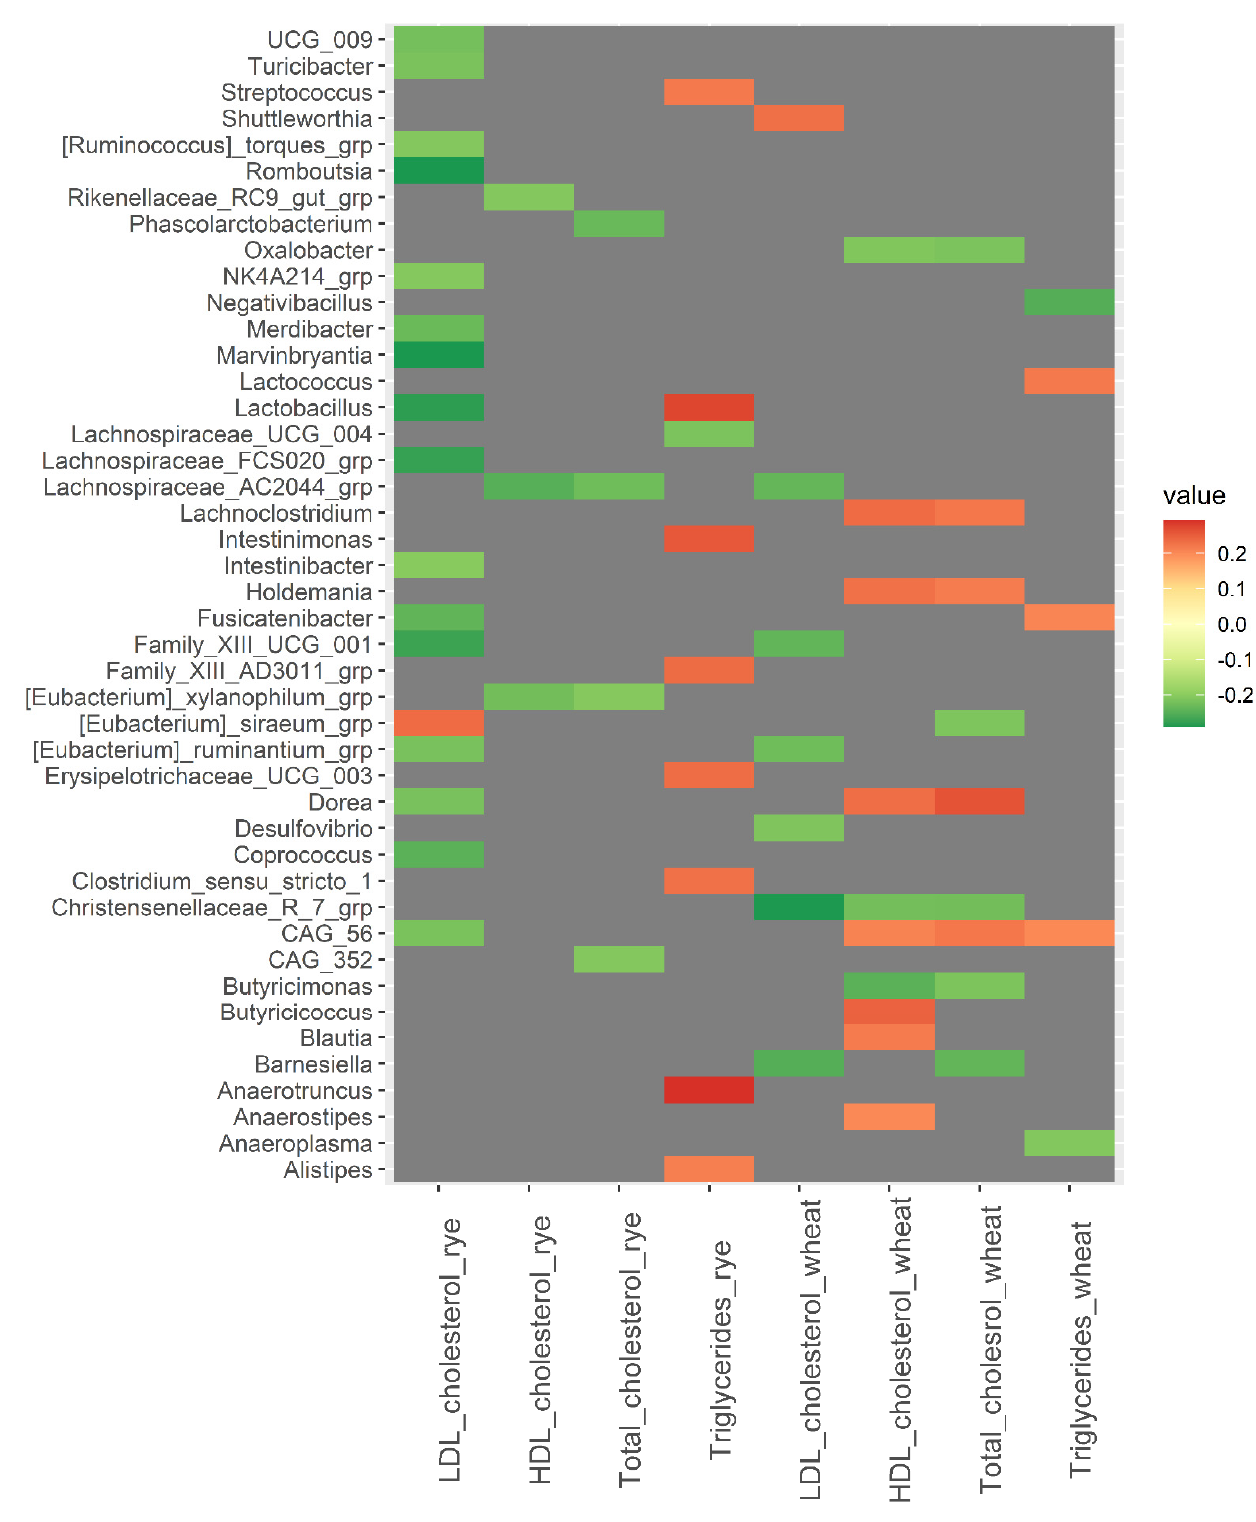
Figure 4. Heatmaps of correlations (Spearman’s rho ) between bacterial abundance at baseline and changes in blood lipids over 12 weeks within the wheat group and the rye group. Only significant correlations with Spearman’s rho ≥ |0.200| are included in the heatmap, while correlations for all 110 bacteria are shown in Supplementary File S2. Abbreviations: LDL, low-density lipoprotein; HDL, high density lipoprotein.